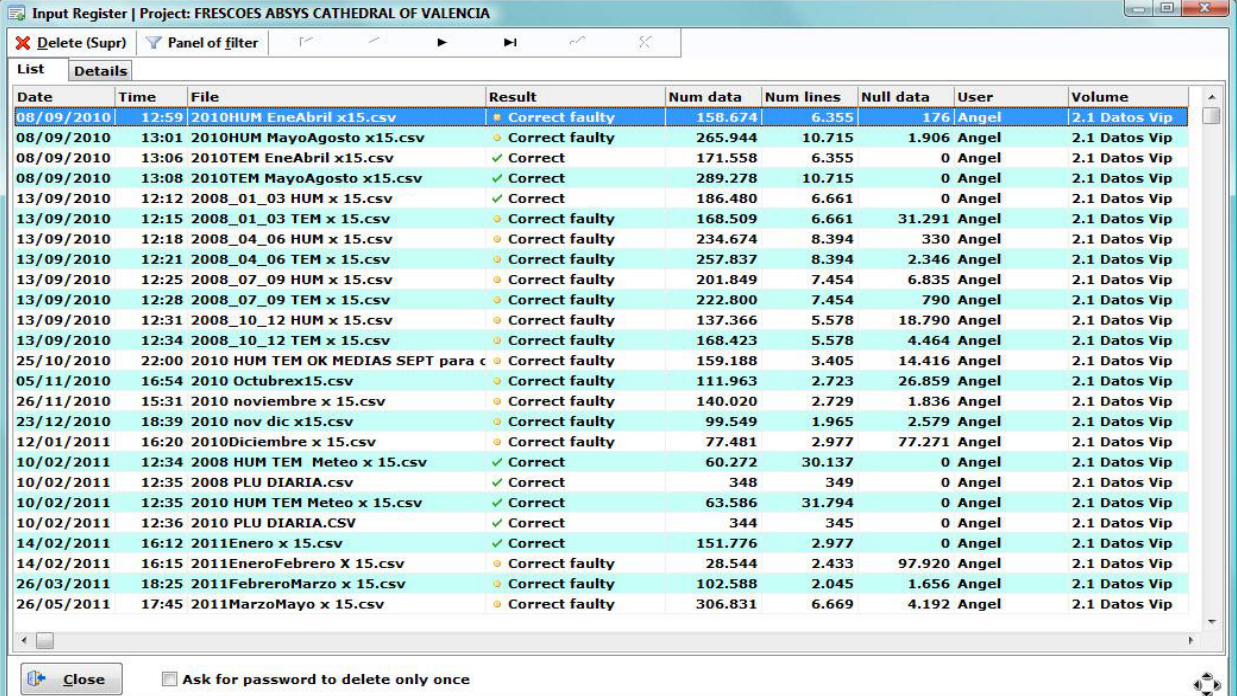
Figure 6. Input register